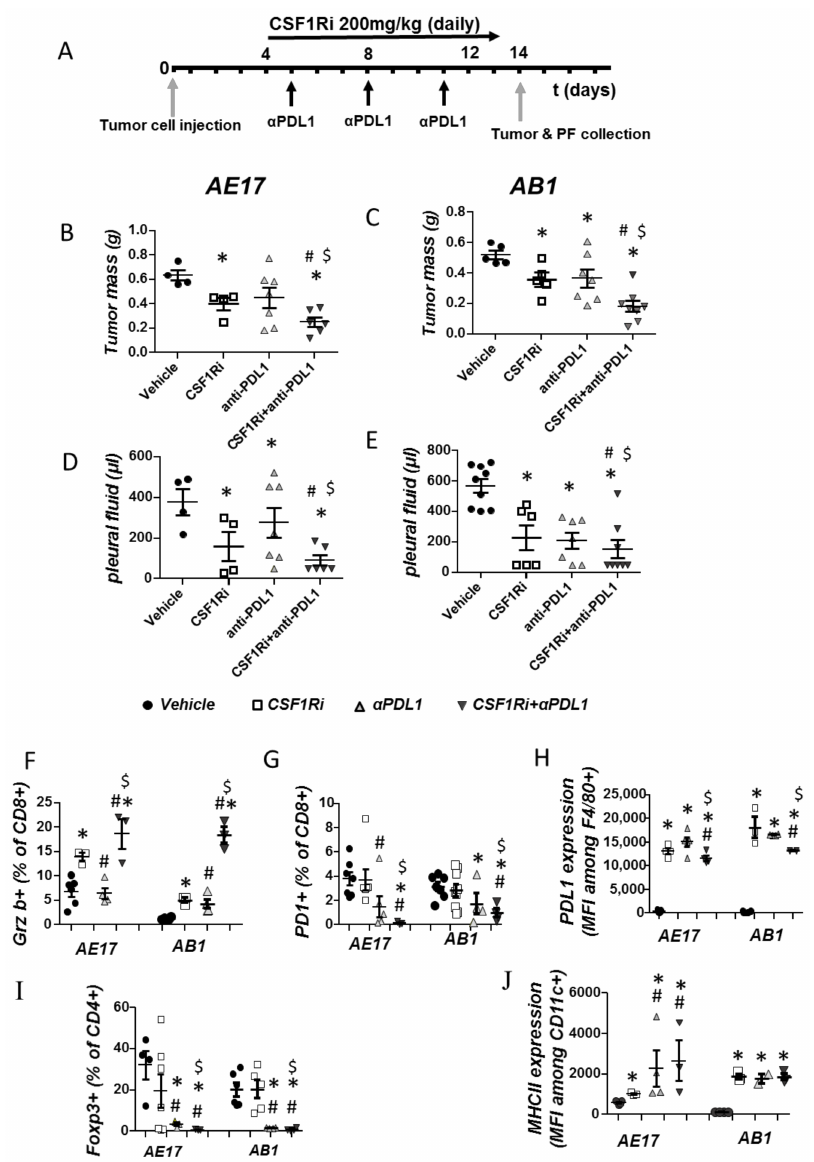
Figure 5. Combined CSF1R and PDL1 blockade abrogates mesothelioma progression by unleashing CD8 activation and by reducing suppressive Tregs. ( A ) AE17 and AB1 cells were intrapleurally injected into syngeneic C57Bl/6 and Balb/c mice, respectively. Mice were administered with anti- PDL1 (200 µ g/dose i.p) every 3 days, CSF1Ri (200 mg/kg b.w, p.o. once daily), anti-PDL1+CSF1Ri or vehicle once daily. Fourteen days later, the mice were sacrificed, and the mesothelioma tumors were excised and weighed ( B , C ), and pleural fluid was retrieved and quantified ( D , E ). Data are presented as mean ± SEM, n = 5–8 from two independent experiments, * p < 0.05 compared to vehicle, # p < 0.05 compared to CSF1Ri, $ p < 0.05 compared to anti-PDL1 group by One-way ANOVA test. ( F , G ) Tumors were analyzed for activated (Granzyme B+) or “suppressed” (PD-1+) CD8+ lymphocytes. ( H ) The expression of suppressive PDL1 by TAMs was determined. ( I ) Tumor infiltration of suppressive T regulatory cells was evaluated. ( J ) Activation of DCs was evaluated by quantifying their MHCII expression. Data are presented as mean ± SEM, n = 5–8 from two independent experiments, * p < 0.05 compared to the vehicle, # p < 0.05 compared to CSF1Ri, and $ p < 0.05 compared to anti-PDL1 group by One-way ANOVA